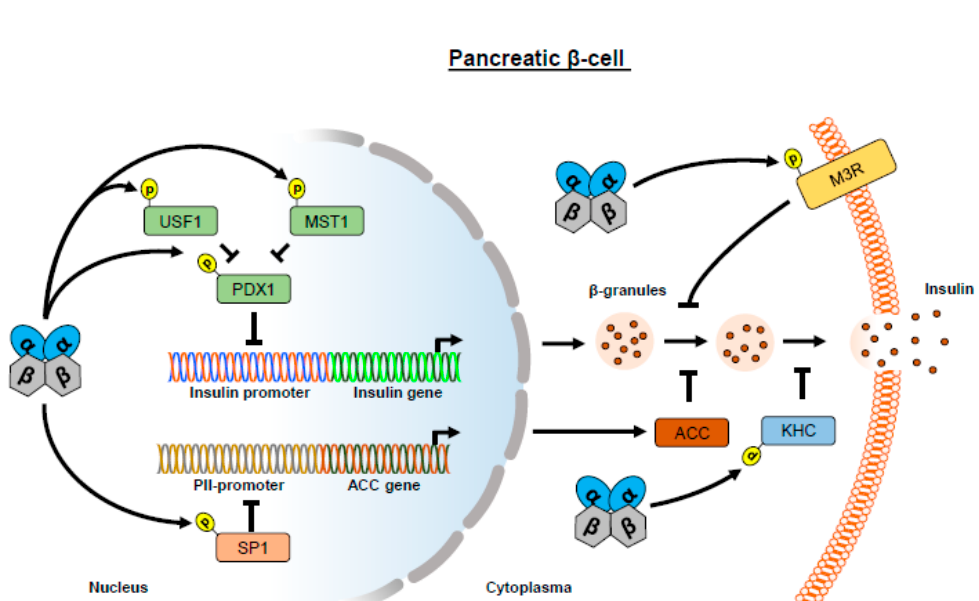
Figure 2. Effect of CK2 on insulin expression and secretion. CK2-dependent phosphorylation of USF1 reduces the expression of transcription factor PDX1, leading to a decreased insulin expression. CK2-induced phosphorylation of PDX1 itself also represses insulin expression by destabilizing